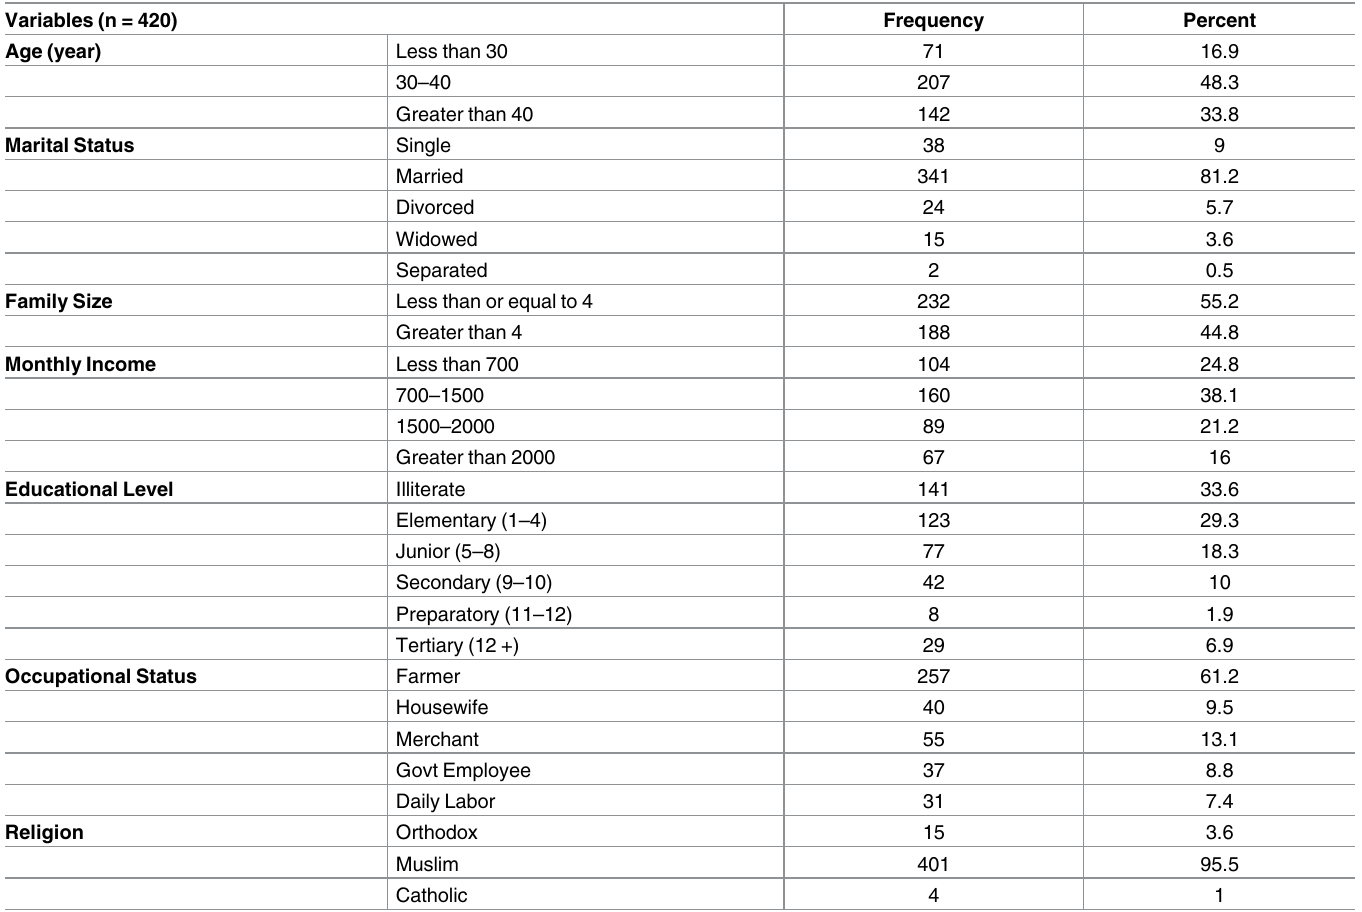
Table 1. Socio-demographic characteristics of population under study,